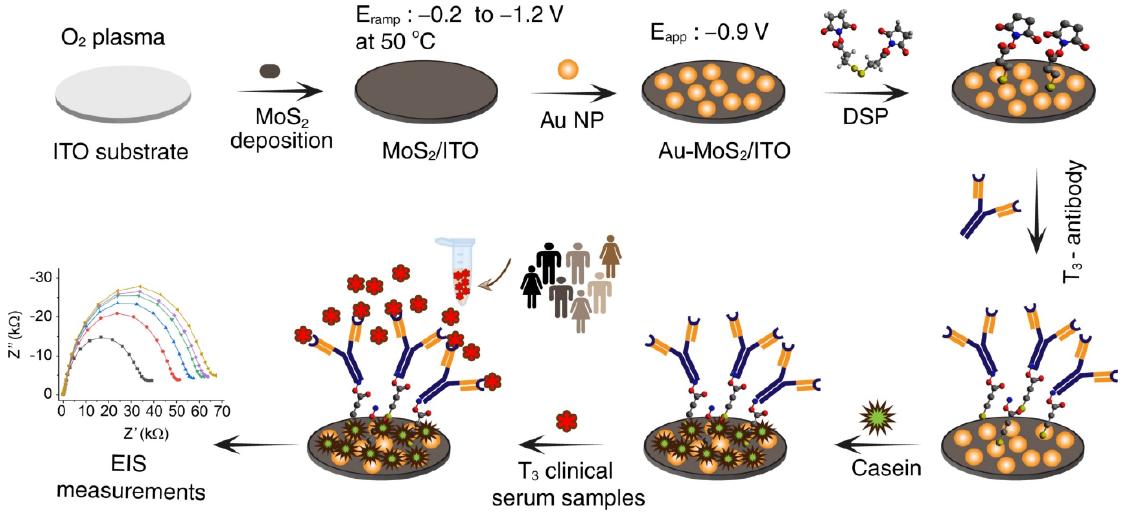
Figure 10. Schematic illustration of the total triiodothyronine (T 3 ) receptive interface fabrication through the immobilization of the antibody on a step-by-step modification process of MoS 2 –Au formation and subsequent functionalization with a dithiobis (succinimidyl propionate) monolayer on an indium tin oxide electrode surface. With increasing concentration of the T3 analyte in serum, the EIS (Nyquist plot) shows increased semi-circle (Rct) for quantification. Reprinted with permission from Ref. [77]. Copyright 2020, Elsevier.